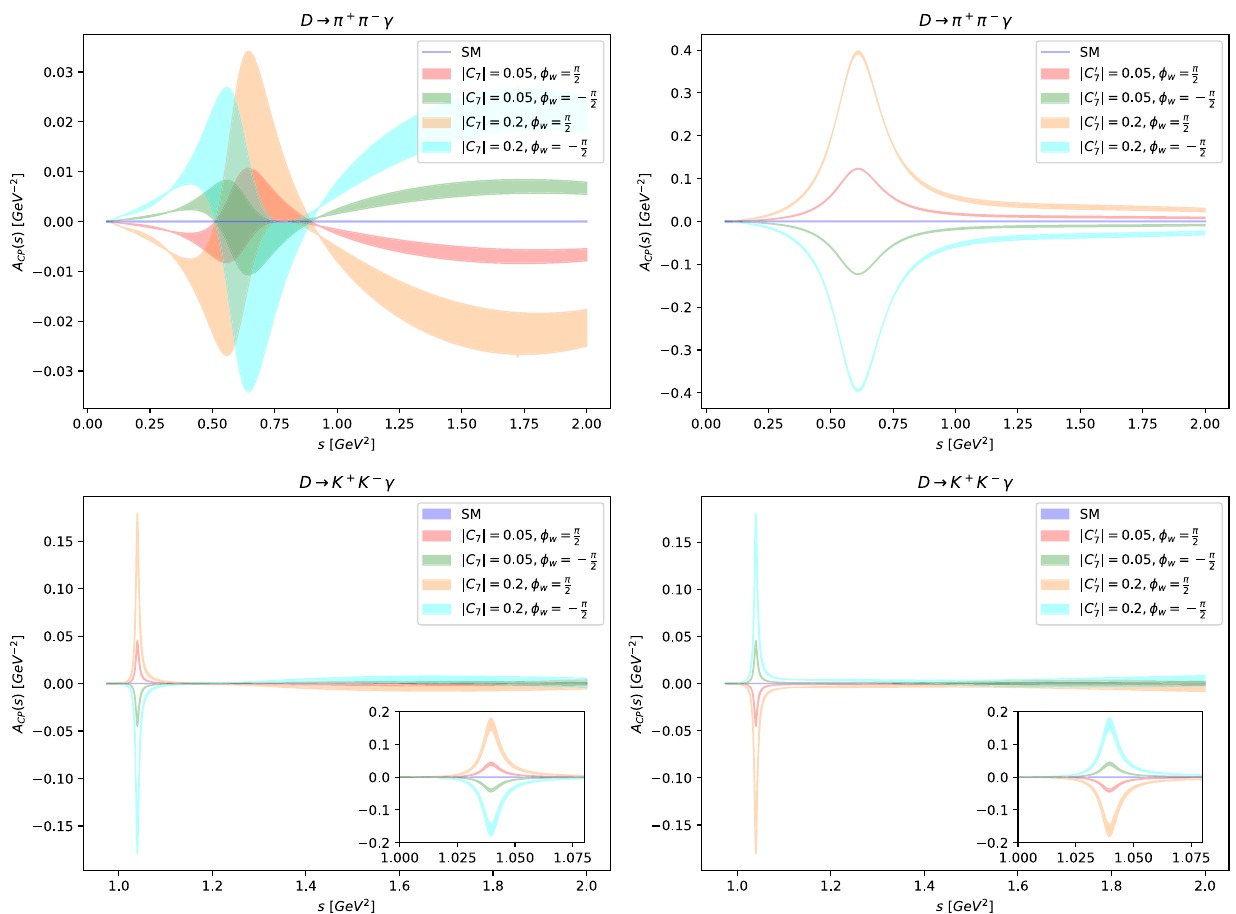
Fig. 12 As in Fig. 11 but for HH χ PT and with cut s ≤ 2GeV 2 to avoid large bremsstrahlung contributions in the